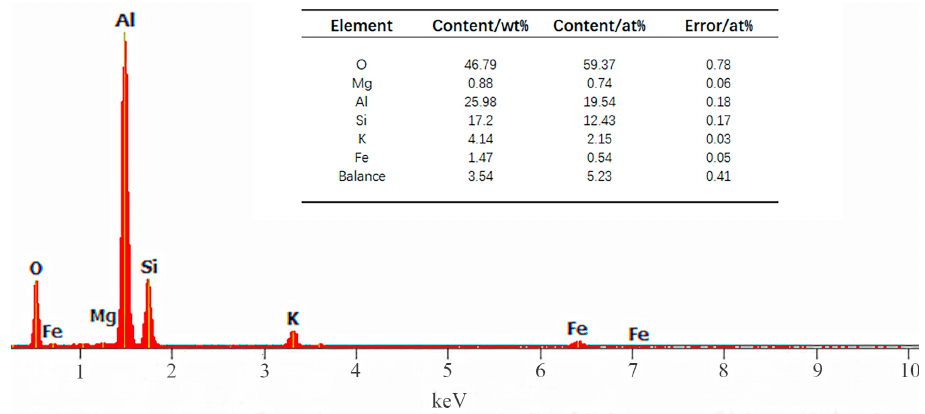
Figure 11. SEM micrographs of worn out surfaces for AlSi5Cu1Mg + 0.6 wt % La alloys subjected to: ( a ) 0.19 m/s sliding velocity and 1.3 MPa normal load; ( b ) 0.19 m/s sliding velocity and 6.3 MPa normal load; ( c ) 0.57 m/s sliding velocity and 1.3 MPa normal load, and the high magnification micrographs are on their right side.